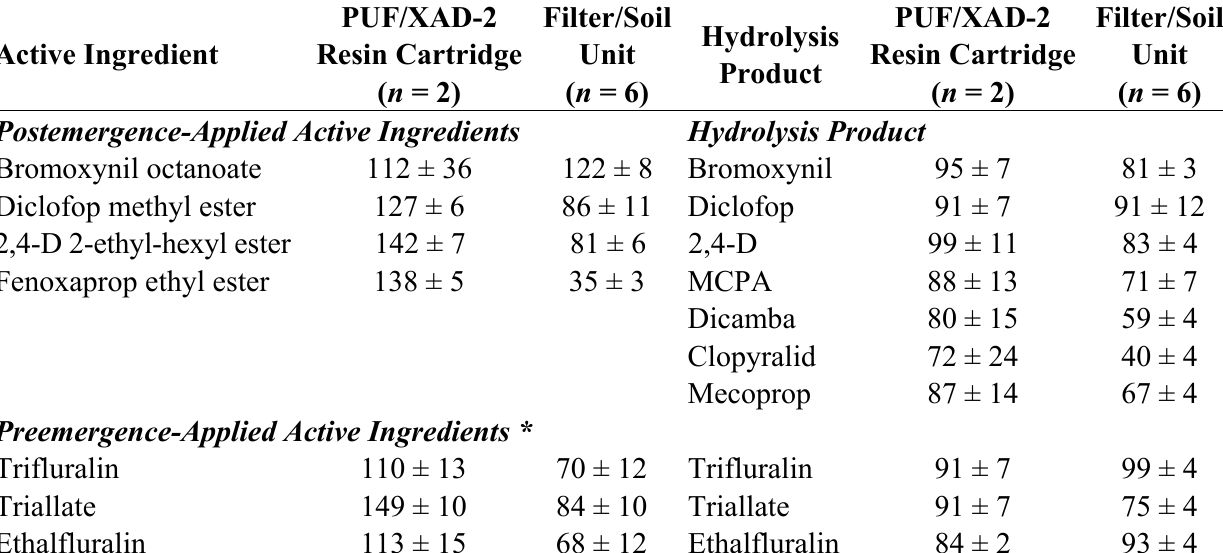
Table 4. Percent recoveries of active ingredients/hydrolysis products from fortified PUF/XAD-2 resin composite cartridges and from glass fibre filter/soil